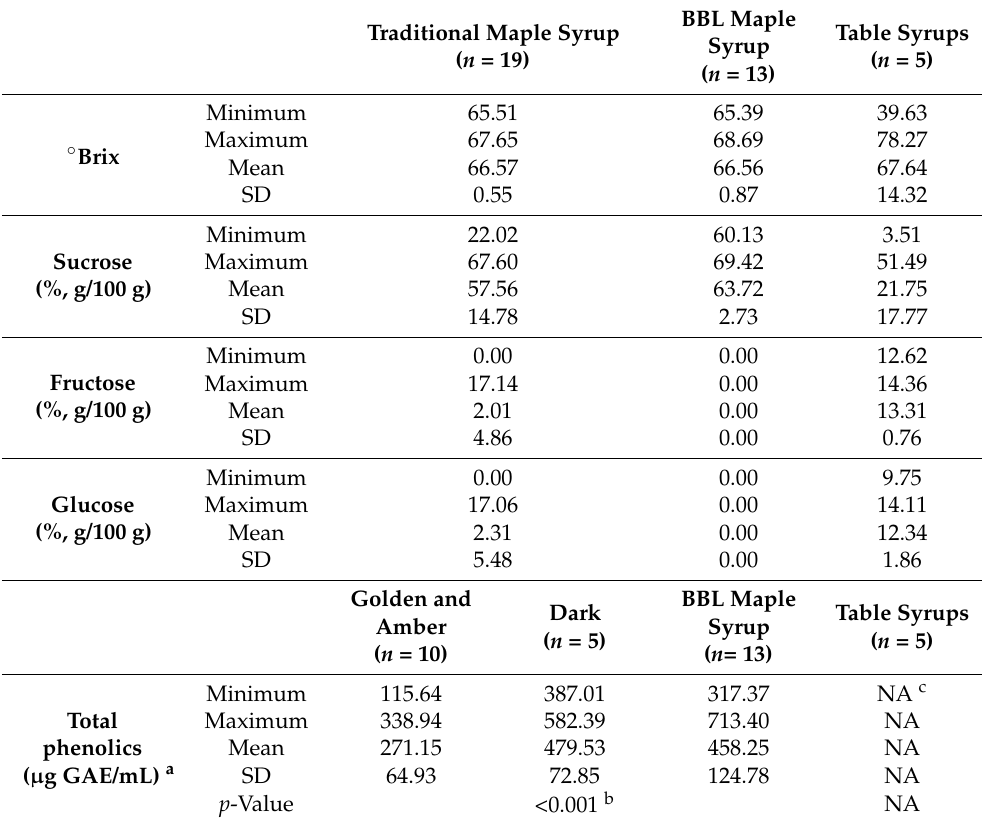
Table 1. Reference analysis results of total soluble solids, sugar (sucrose, fructose, and glucose), and total phenolics in traditional, bourbon barrel (BBL)-aged maple syrup and commercial table